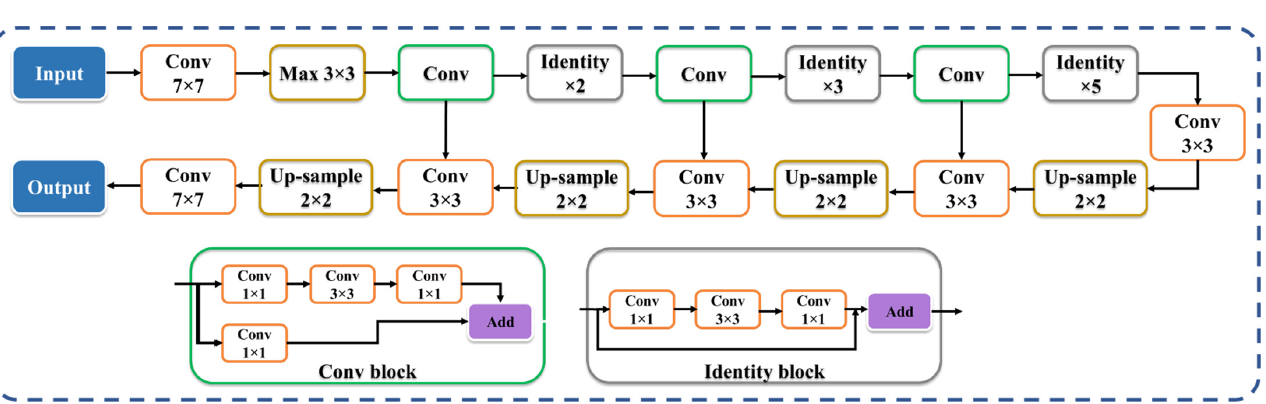
Figure 8. VGG ‐ UNet’s architecture.